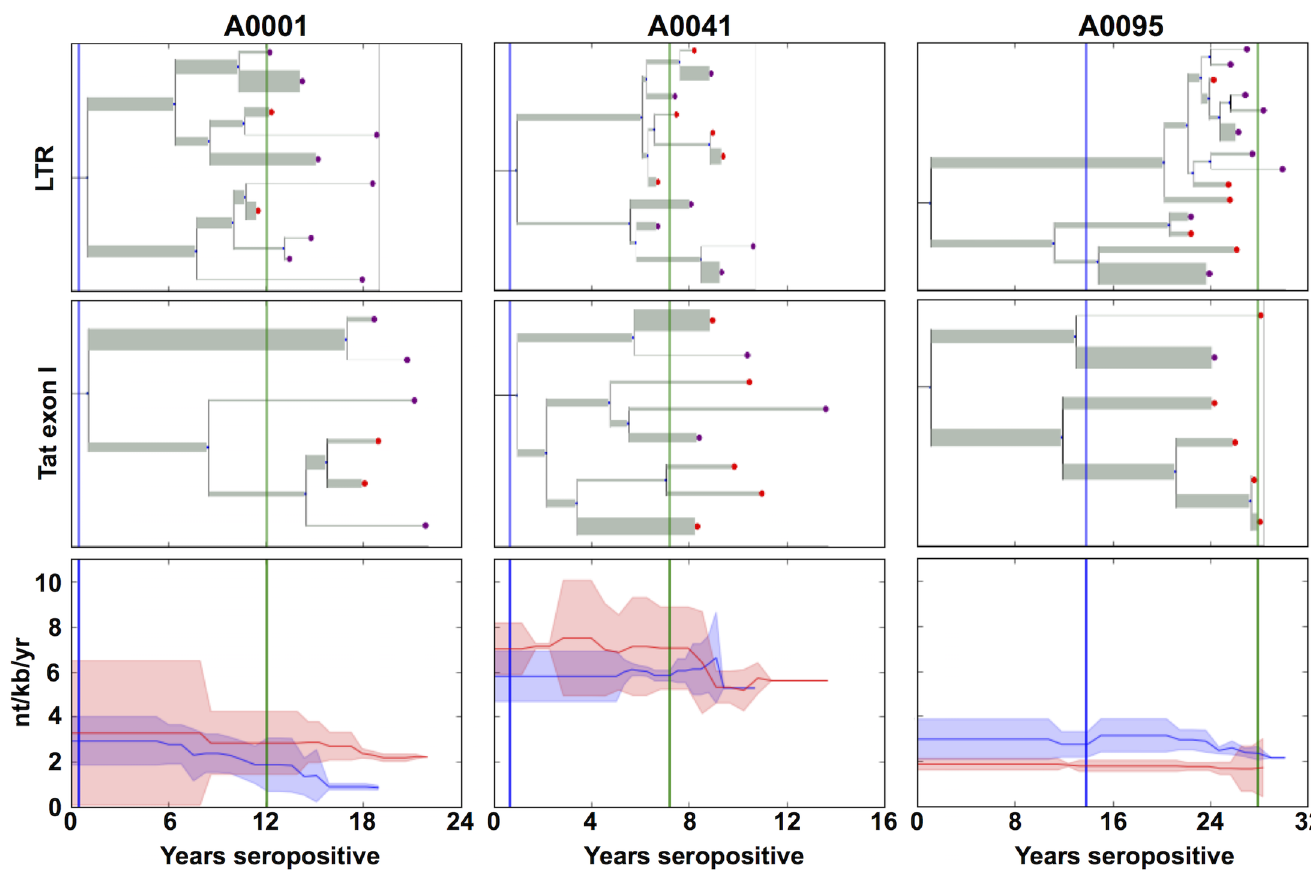
Fig 2. The mutation rate of HIV varies over time as determined by BEAST analysis. BEAST trees from three representative patients (A0001, A0041 and A0095) are shown for both the LTR (Top) and tat exon 1 (Middle) regions The width of the branch indicates the rate of mutation across the branch and the branch-length represents the time since divergence. The purple nodes indicate PCR Reads, the red nodes 4.4 Kb Fragment Reads, and the green nodes indicate Clone Reads. (Bottom) The time-series of each patient was synchronized such that the estimated time of infection for all samples have been shifted to 0 years. The red line shows the average mutation rate of tat exon 1 and the red shadow shows the 95% confidence interval of the estimate. The blue line shows the average mutation rate of the LTR and the blue shadow shows the 95% confidence interval of the